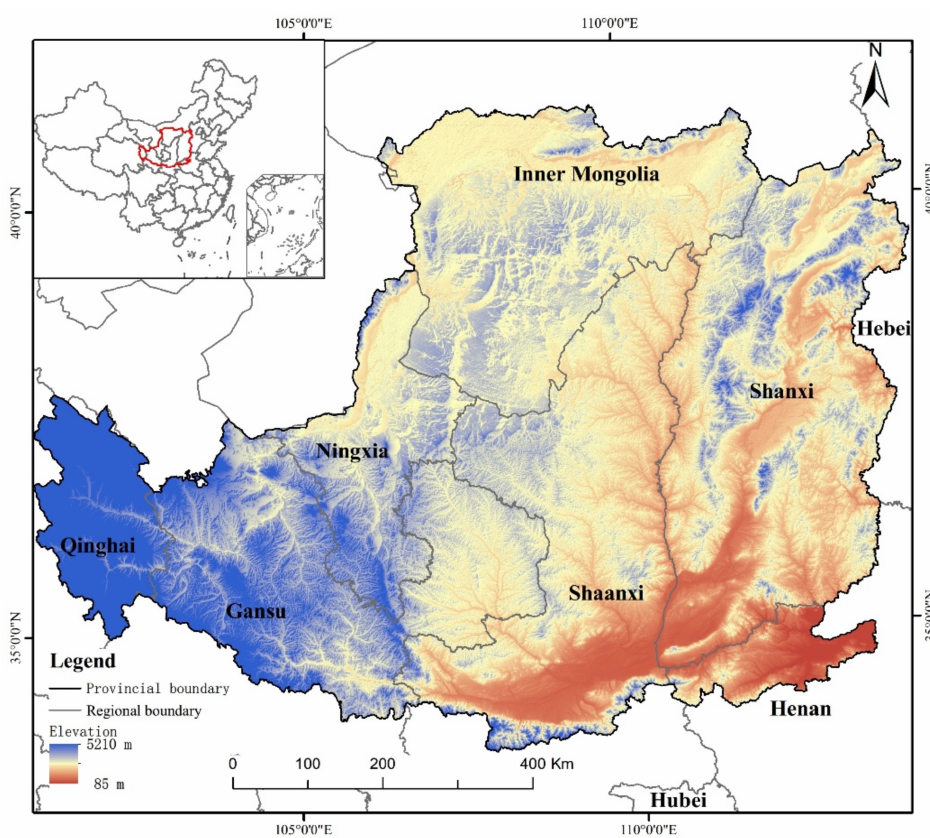
Figure 1. The location map of the Loess